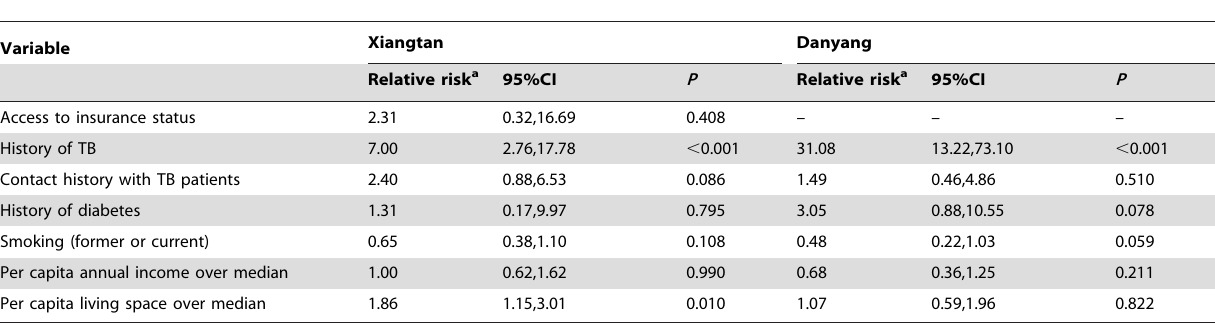
Table 4. Relative Risk of Exposed Factors Associated with TB in the Study, 2009–2011.